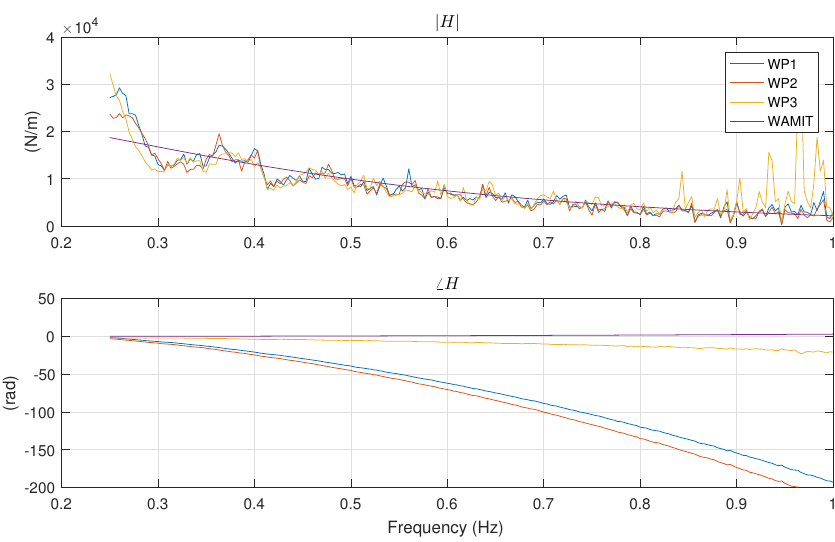
Figure 27. Excitation FRFs for different wave probes and comparison with